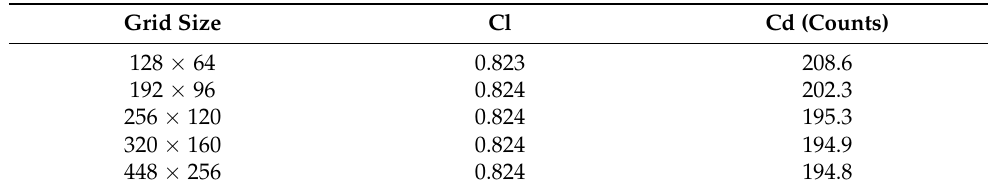
Table 1. Grid convergence study of aerodynamic performance for RAE2822.